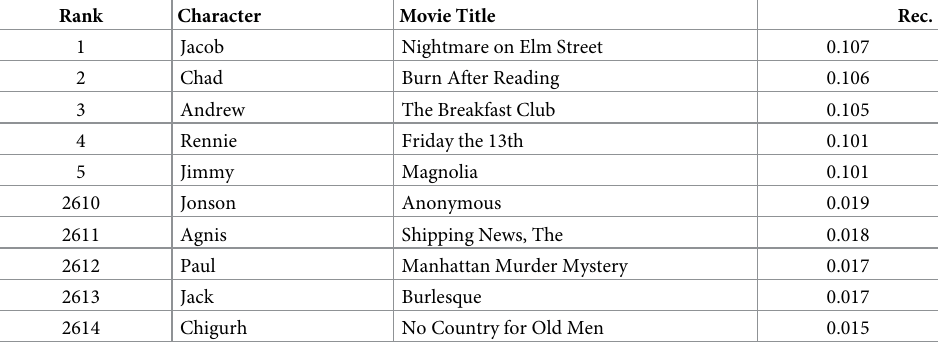
Table 4. Characters with highest/lowest recovery rate (rec.) in the v–a space. Note that the bottom rank number is less than the total number of characters in the data because some characters had insufficient number of displacements to obtain reliable